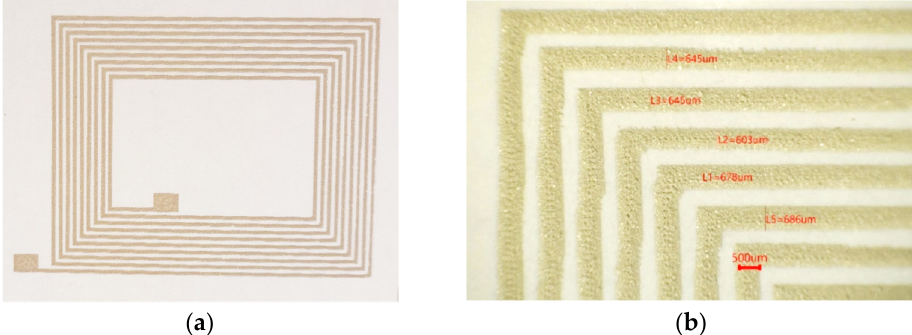
Figure 8. ( a ) Printed NFC antenna onto CNC-coated Klabin substrate and ( b ) magnification of the printed lines with the optical microscope. Table 4. Measurements of performance of printed NFC